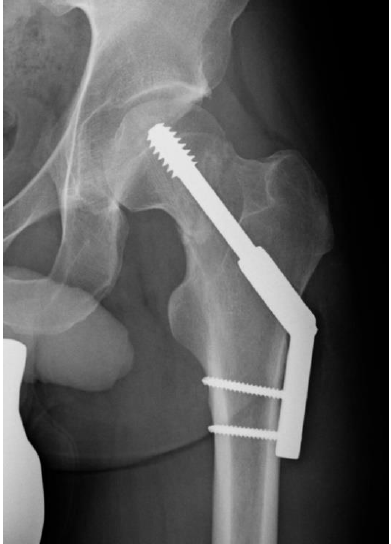
Figure 1. Undisplaced femoral neck fracture after dynamic hip screw (DHS) implantation in anteroposterior view.